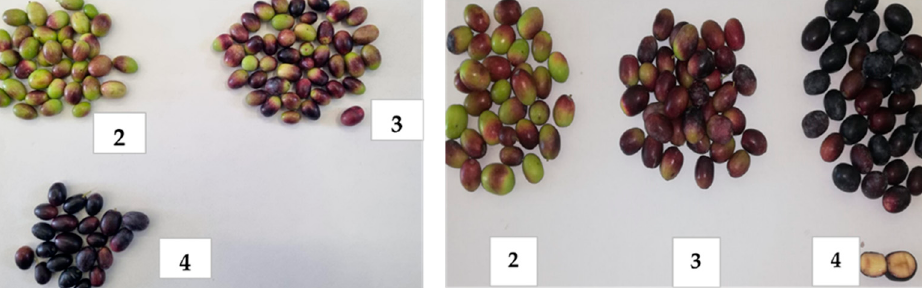
Figure 2. Determination of epicarp color of untreated ( left ) and kaolin-treated ( right ) drupes at harvest with the Jean index (2: yellow skin with red spots, 3: light red or light purple skin,4: black skin and green flesh).